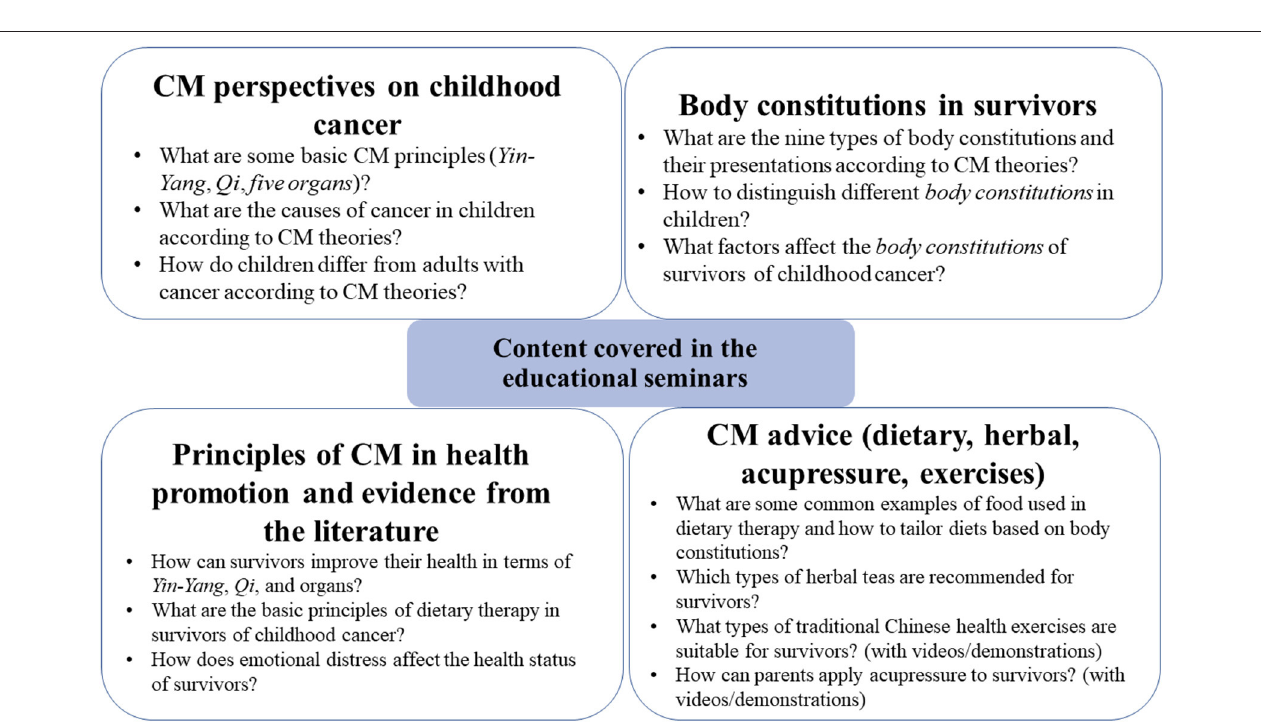
FIGURE 2 | Content covered in the educational